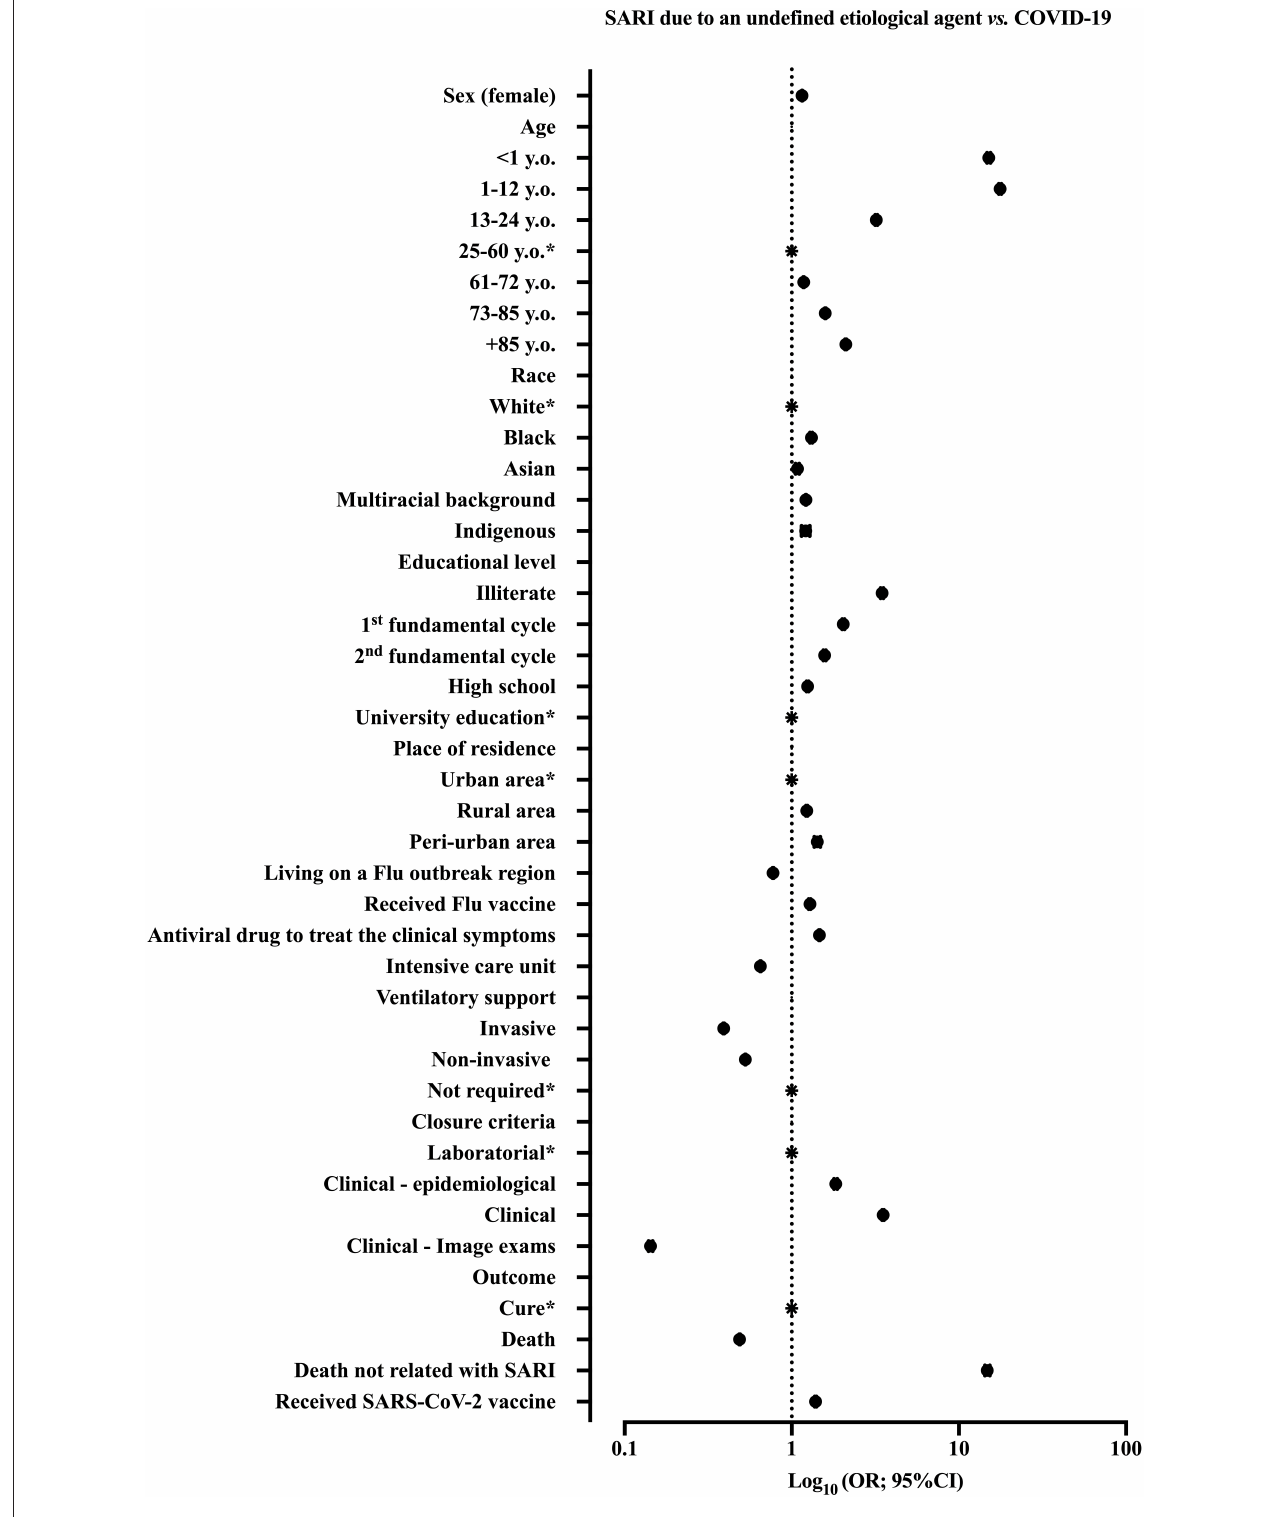
FIGURE 2 | We demonstrated the result of bivariate analysis to identify the patients’ features associated with severe acute respiratory infection (SARI) diagnosis. We compared the patients with SARI due to an undefined etiological agent vs. COVID-19. We demonstrated the odds ratios (ORs) and 95% confidence interval (95%CI). SARS-CoV-2, Severe Acute Respiratory Syndrome Coronavirus 2; y.o., years old. *Reference group.